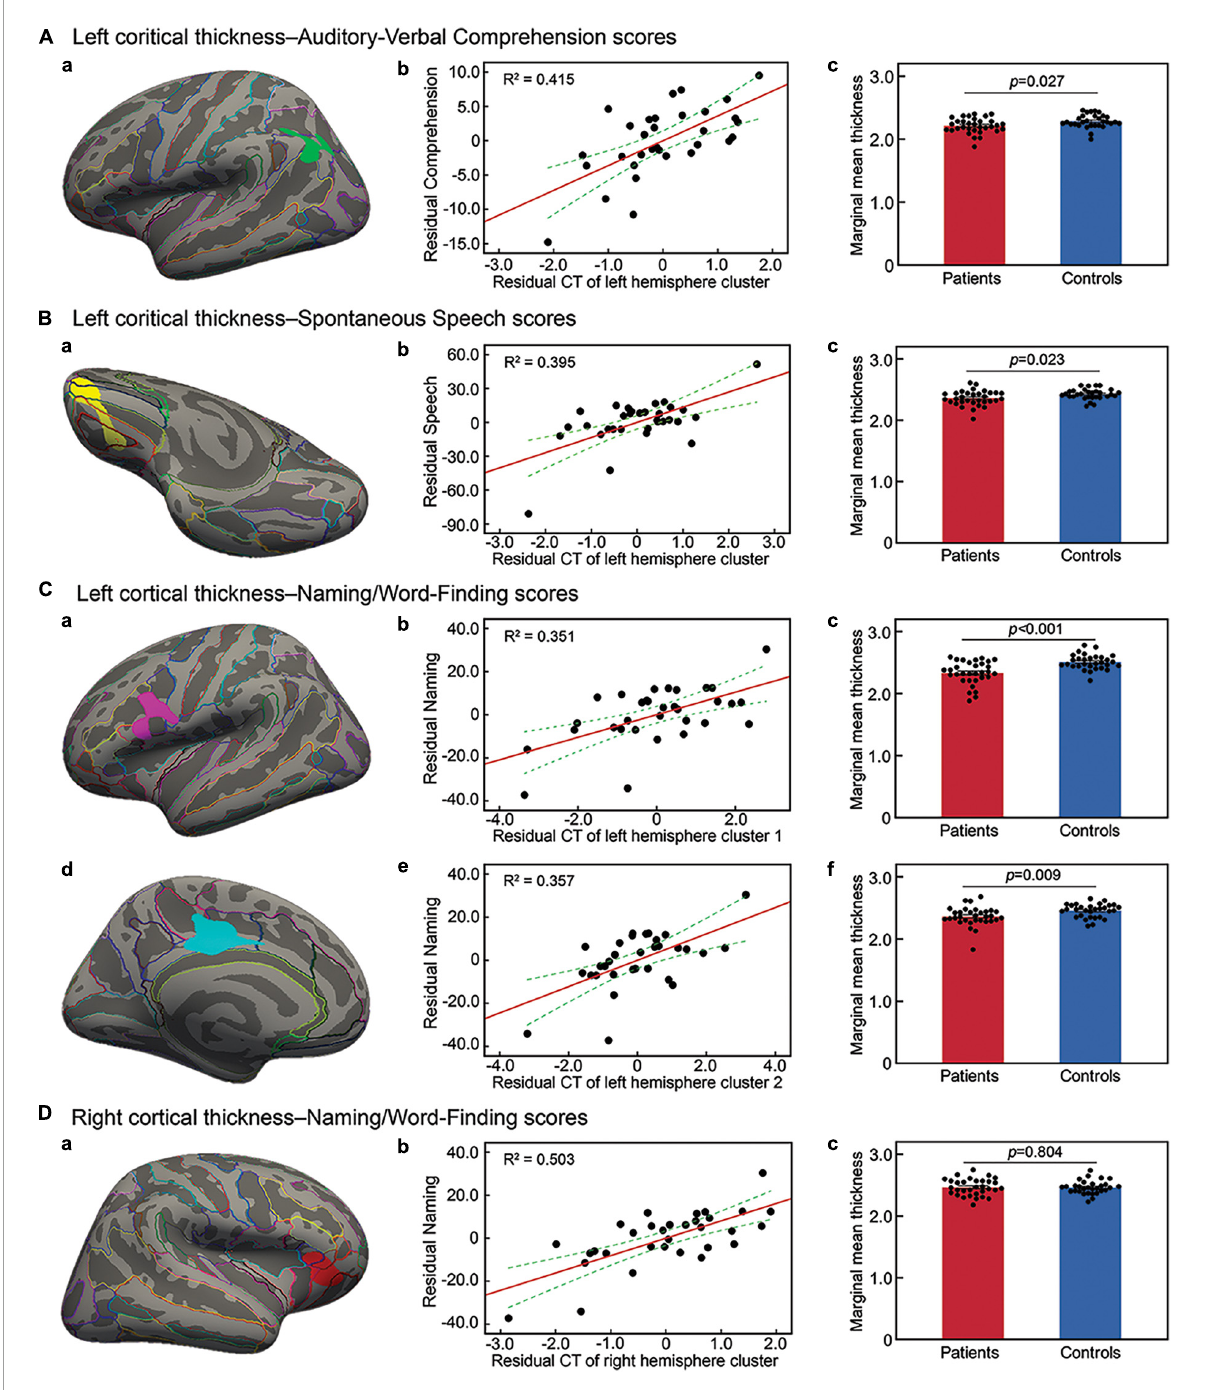
FIGURE2 Cortical thickness in brain regions related to language outcomes. Surface representation of the significant clusters of cortical thickness related to the auditory-verbal comprehension score in the left inferior parietal cortex and superior temporal gyrus (Aa) , the spontaneous speech score in the left orbitofrontal gyrus (Ba) , and the naming/word finding score in the left inferior precentral gyrus (Ca) , left posterior cingulate gyrus (Cd) , and right orbitofrontal gyrus (Da) . All analyses were performed by controlling for demographic variables and lesion size, and corrected at a voxel-wise threshold of P < 0.005 and a cluster-wise level of P < 0.05, determined by Monte Carlo Simulation. (Ab–Cb,Ce,Db) Scatter plot showing partial regression using language scores as dependent variables and cortical thickness (CT) of clusters as independent factors by controlling for the above key variables (all P < 0.001). (Ac–Cc,Cf,Dc) Cortical thickness changes in each identified cluster in patients relative to controls factoring out demographic